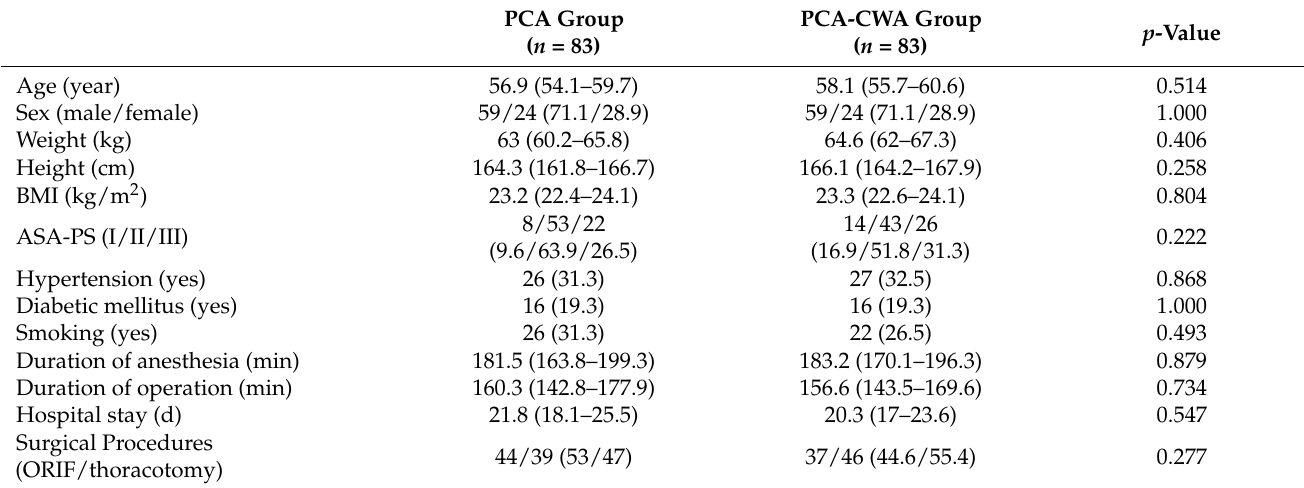
Table 2. Demographic and clinical data after propensity score matching.